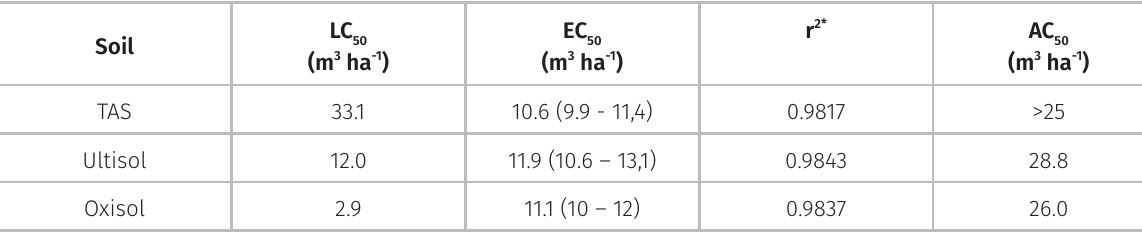
* r 2 for non-linear regression analysis for EC